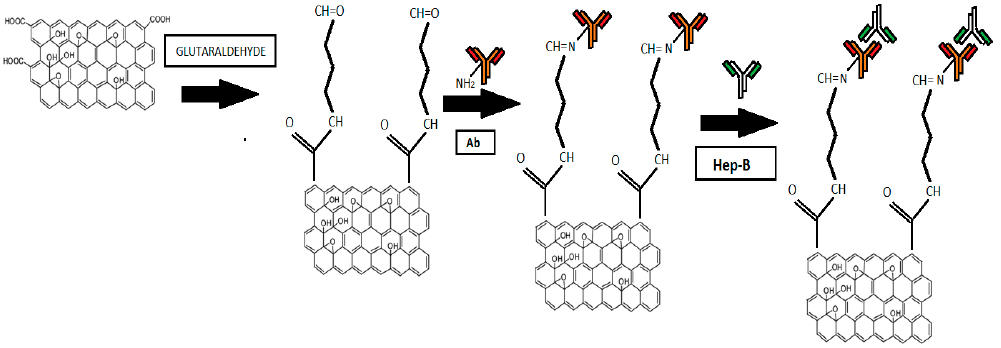
Figure 1. Antigen binding with grapheme.